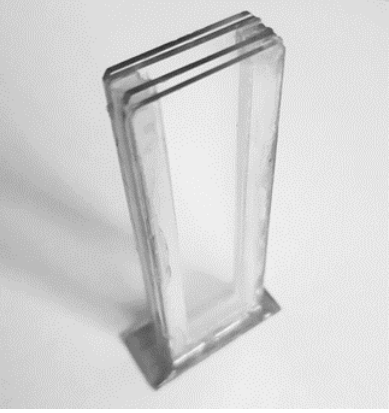
Figure 2. Phononic crystal sensor used for the experimental realizations.